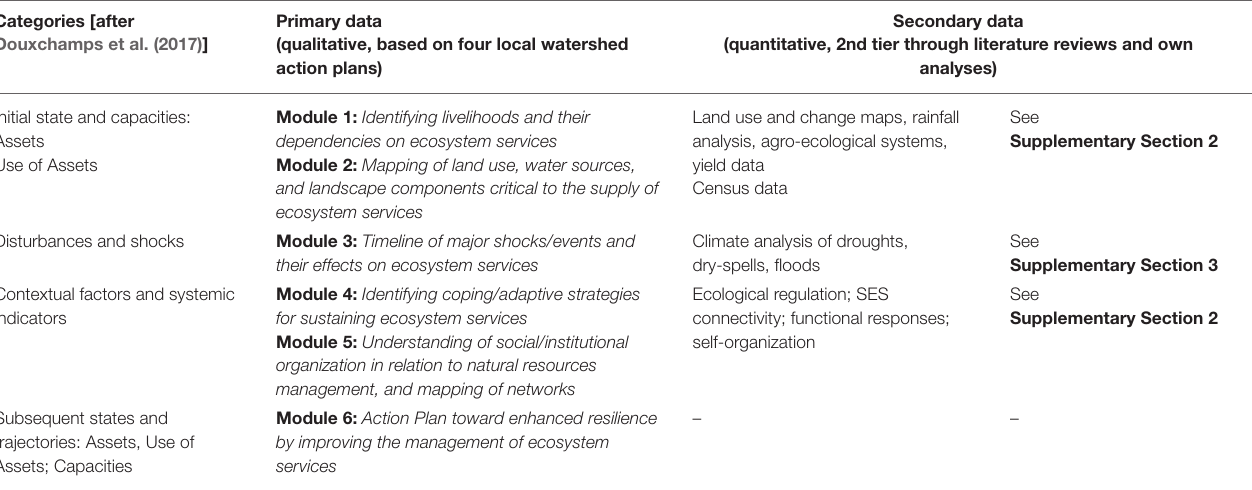
TABLE 1 | List of indicator categories indicators [adopted from Douxchamps et al. (2017)] and sources of data for measuring the resilience of the agro-ecological systems in G1, G2, E1, and E2 watersheds [adopted from Douxchamps et al. (2017)]. Categories [after Douxchamps et al.